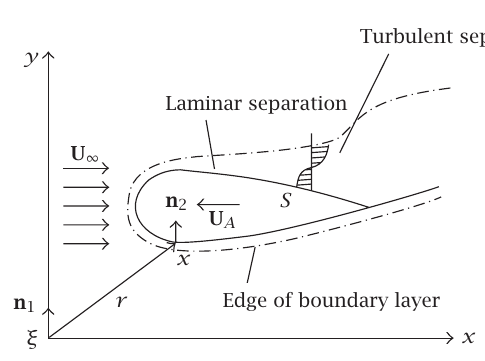
Figure 4.1 . Laminar and turbulent boundary layer model for